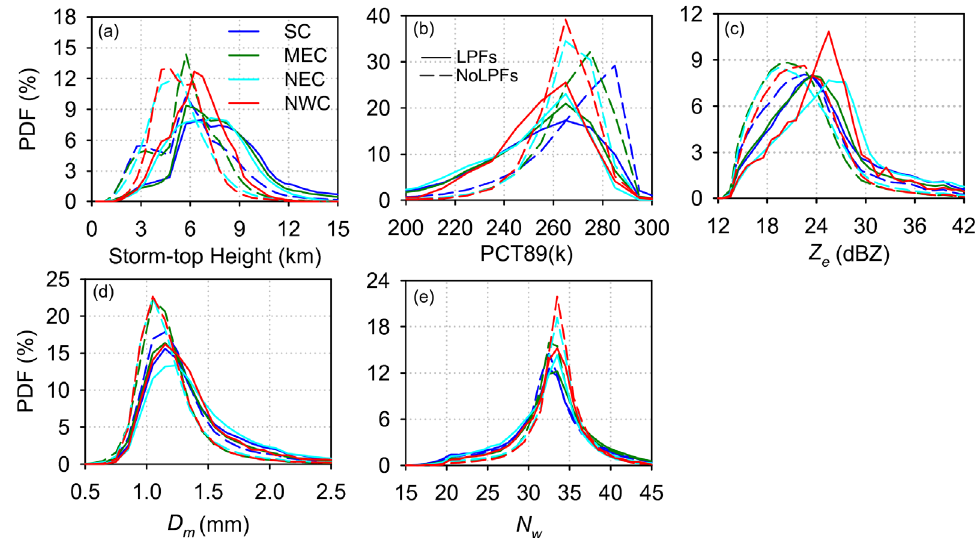
Figure 4. Probability distributions (%) of ( a ) storm-top height, ( b ) PCT89, ( c ) Z e at 1 km above the SH, ( d ) D m at 1 km above the SH and ( e ) N w at 1 km above the SH over SC, YHRB, NC and NEC for LPFs (solid lines) and NLPFs (dashed lines) during the summer for the time period 2014–2021. The bin sizes for storm-top height, PCT89, Z e , D m and N w are 0.5 km, 10 K, 1 dBZ, 0.1 mm and 1.0, respectively.